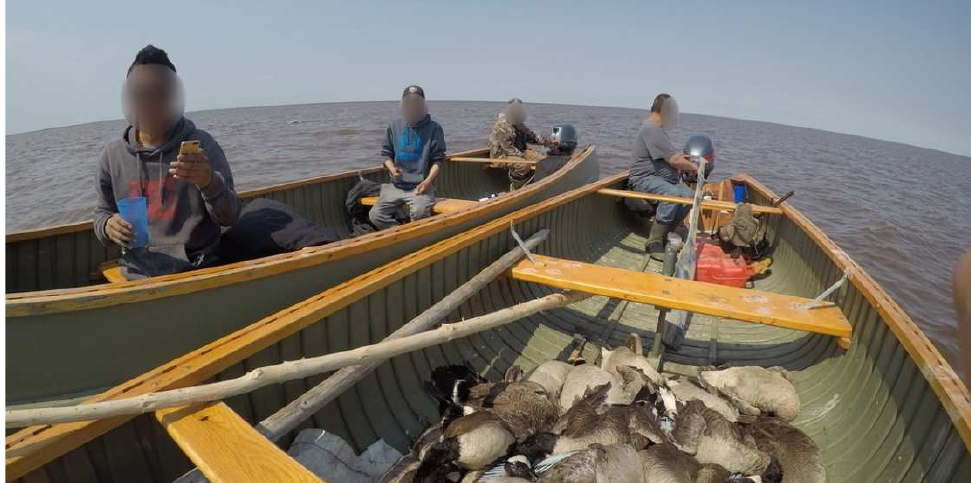
Figure 3. An Elder, on-the-land expert, and youth crossing paths in the bay while on canoes harvesting goose.